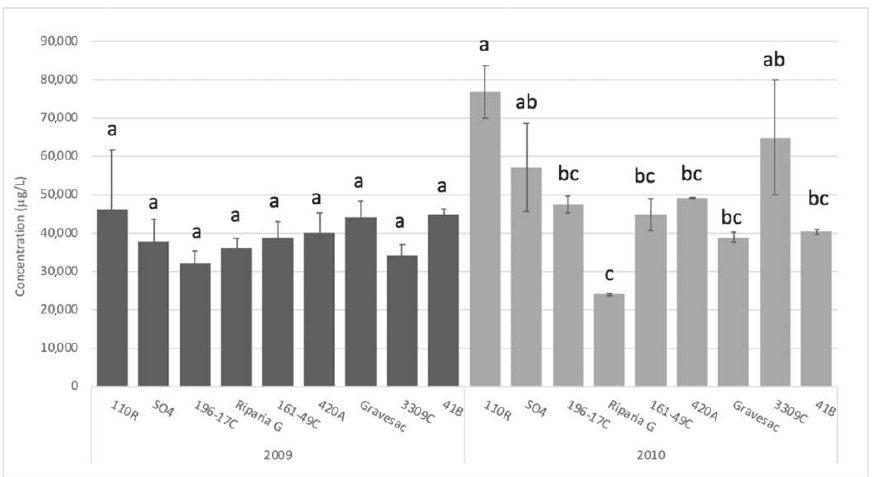
Figure 1. Total volatile concentration of Albariño wines from different rootstocks over two vintages (2009 and 2010). Error bars correspond to SDs. Different letters (a, b and c) indicate significant differences among rootstocks in each season according to Fisher’s Least Significant Difference (LSD) test ( p <